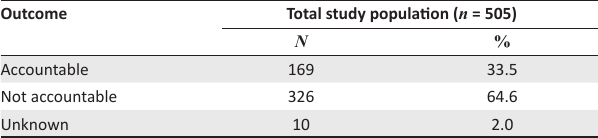
TABLE 1: Outcomes of the observati after the 30-day observation period. Outcome